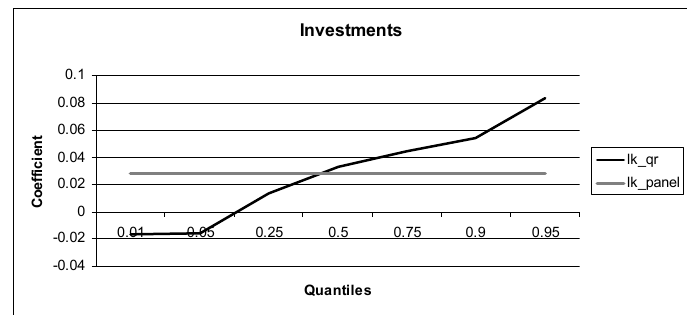
Figure 9 – Quantile Regressions versus Panel Regression estimates for Exporters: Physical Invest- ments.